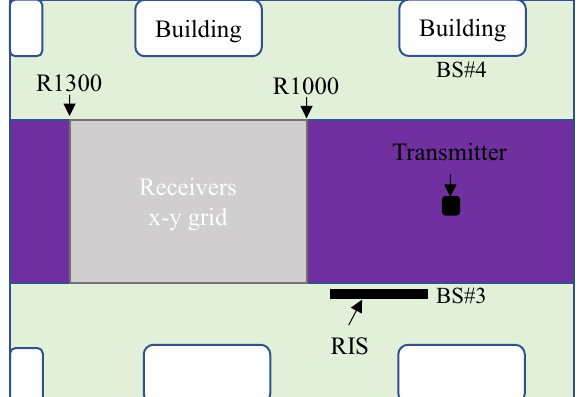
Fig. 2 The ray tracing scenario ‘O1’ from [33]. The BS#3 is selected to be the RIS while the transmitter is fixed at the position of raw R850 and column 90. The receiver can be positioned at any 54,300 points within the x–y grid between raw R1000 and R1300. These points constitute the dataset which is split into 80% training set and 20% test